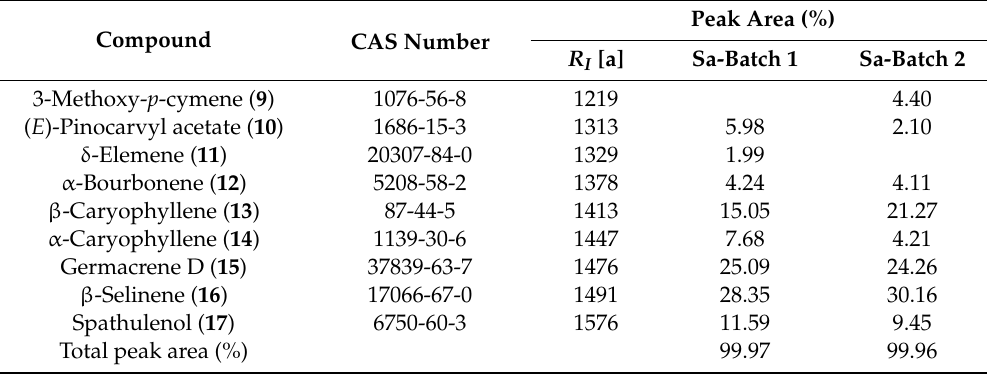
Table 2. GC-MS identified compounds from the essential oils of S. amarissima .